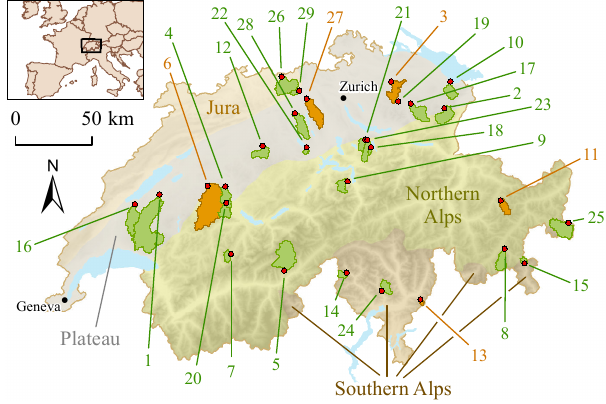
Figure 1. Locations of the gauging stations selected for the eval- uation of the physics-inspired and standard statistical models. The stations are displayed as red points and their associated catchments as green or orange areas, depending on whether they are used to calibrate or validate the model. The four main climatic regions of Switzerland – the Jura mountains, Plateau, Northern Alps and Southern Alps – are displayed in different colours. The numbering corresponds to Table